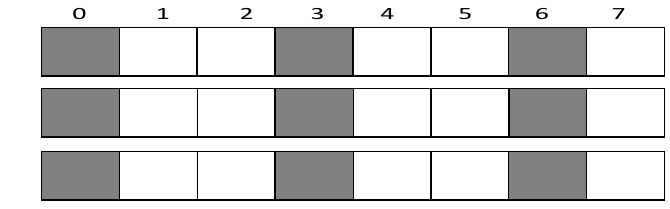
Figure 13. Minimum transmission delay model.